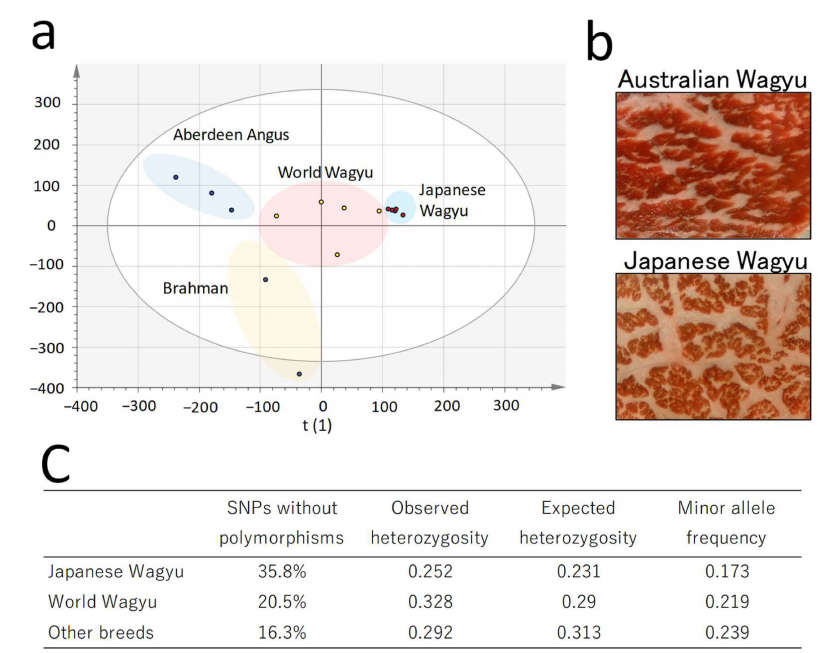
Figure 1. Genetic diversity map of global Wagyu cattle. The results of bovine single-nucleotide polymorphism arrays using 15 cattle, including Japanese Wagyu (five distinct producing regions in Japan), World Wagyu (one from USA, three from Australia, and one from New Zealand), and other breeds (three Aberdeen Angus and two tropical Brahman). ( a ) Score plot of principal component analysis detailing the relationship between Wagyu beef (scaling, UV; R2X (1) = 0.114; R2X (2) = 0.106). ( b ) Photograph of a cross-sectional view of the adductor muscle of Japanese and Australian Wagyu. ( c ) Comparison of genetic diversity among the Wagyu breeds. The table lists the results of each item in the PLINK whole-genome association analysis (each item n =